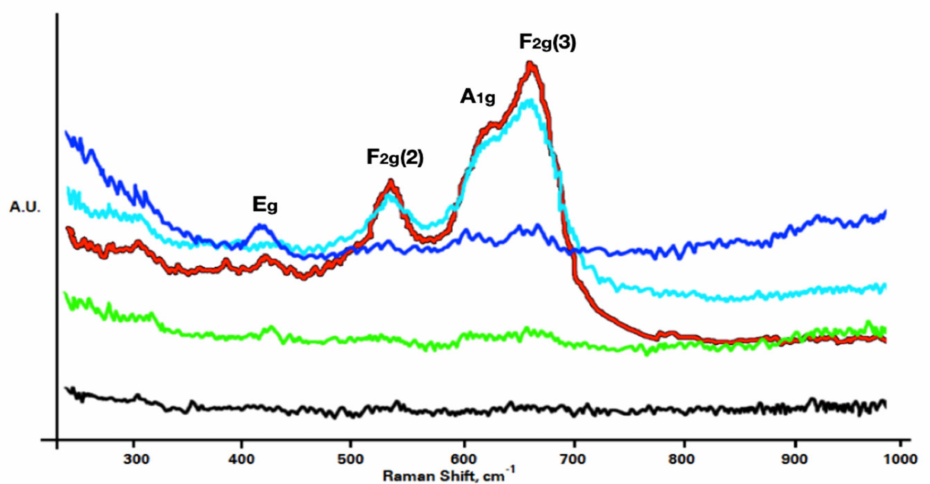
Figure 6. Raman spectra at 785 nm revealing vibrational modes for oxide scales. The black, green, blue, light blue, and red indicate the as-received, 500, 600, 700, and 800 ◦ C samples,